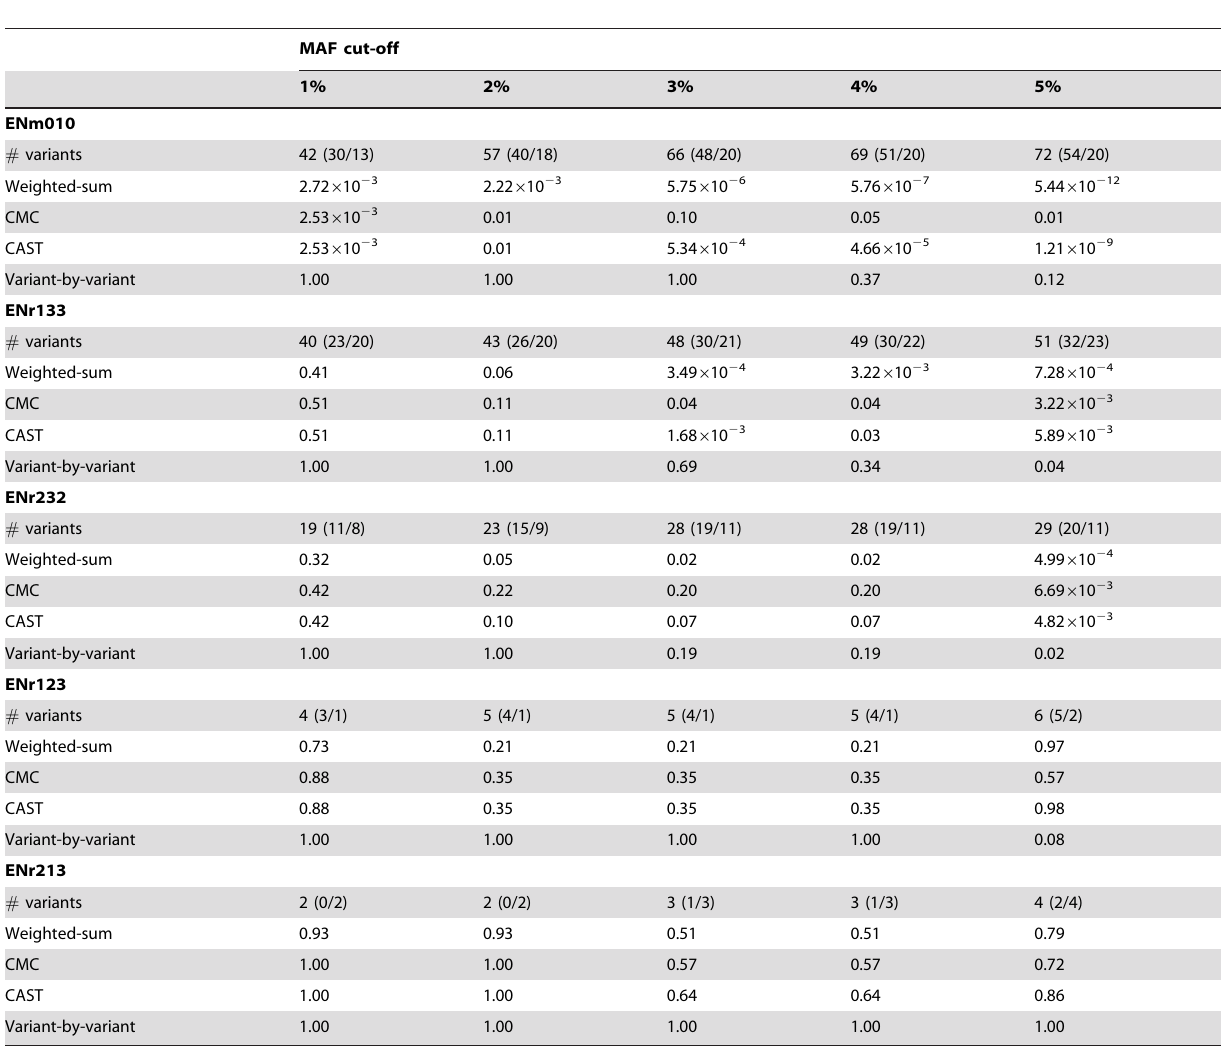
Table 2. Tests for excess of rare exonic variants in the YRI population compared to the CEU